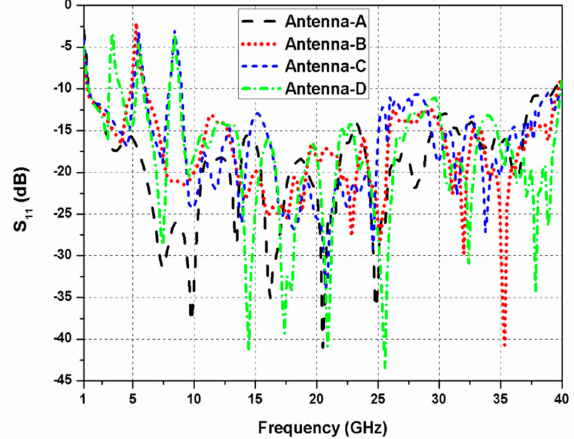
Figure 3. Reflection coe ffi cients of the geometrical design